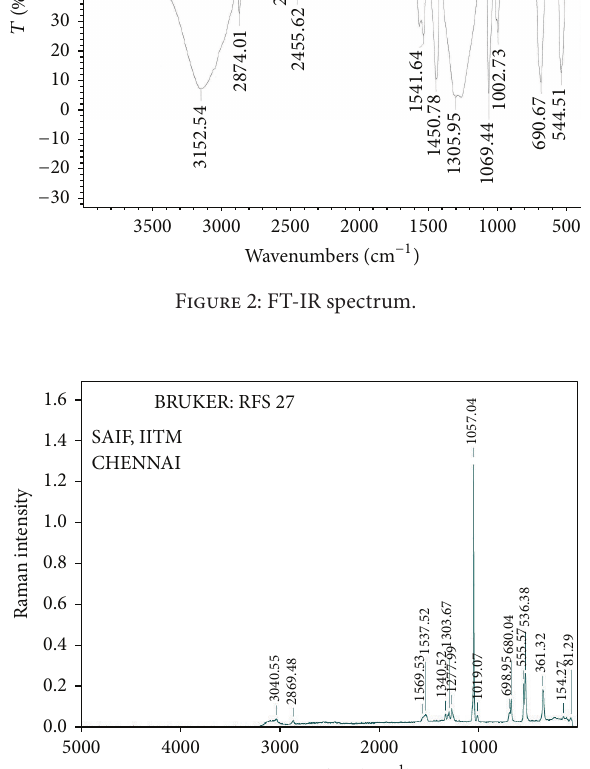
Figure 3: FT-RAMAN